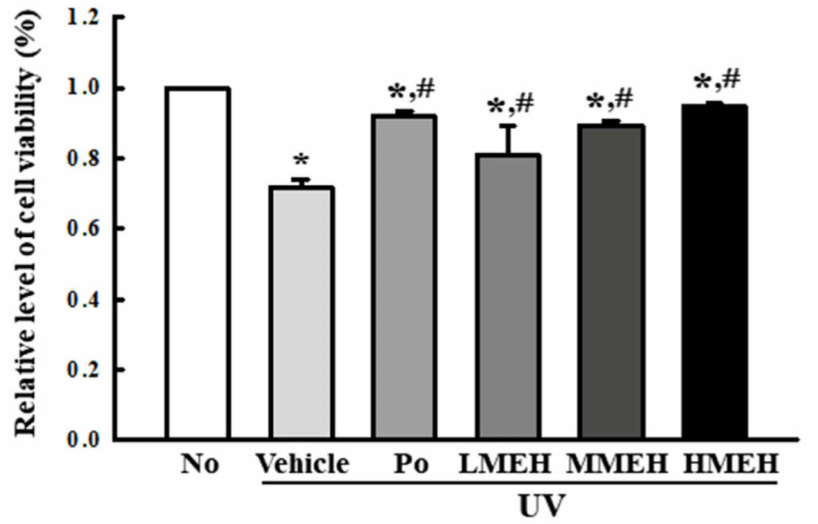
Figure 5. Cytotoxicity of UV+MEH-treated NHDF cells in normal human dermal fibroblasts. The optical density of MTT assay was measured in triplicates and the assay was repeated for three times. Data are reported as means ± SD. *, p < 0.05 relative to the untreated group. #, p < 0.05 compared to the UV + Vehicle group. Abbreviations: MTT, 3-(4,5-dimethylthiazol-2-yl)-2,5-diphenyltetrazolium Bromide; Po, Positive control; MEH, Methanol extract of Hygrophila erecta (Brum. F.)